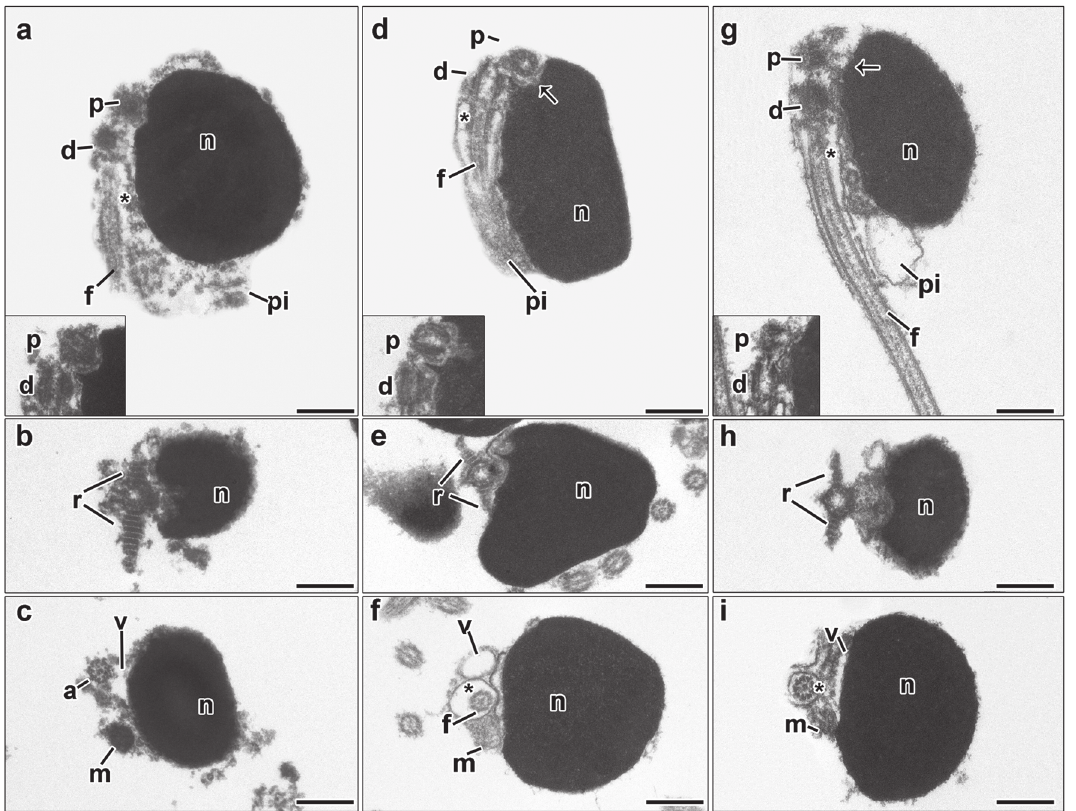
Fig. 2. Spermatozoon of Lebiasina aff. festae ( a, b, c ), L. bimaculata ( d, e, f ) and L. erythrinoides ( g, h, i ). a, d, g : longitudinal sections. b, c, e, f, h, i : transverse sections from top to posterior region. The nucleus (n) of all species is drop-shaped and slightly elongated towards the flagellar axis. The flagellum (f) lies lateral to the nucleus. The centriolar complex (p, d) and nuclear fossa (arrow) is superolateral. Note the presence of the striated rootlets (r) on opposite sides of the distal centriole (d). The proximal centriole (p) is slightly oblique relative to the distal centriole (d) (a-inset, d-inset, g-inset). The cytoplasmic canal is present (asterisk). The midpiece (pi) is short, asymmetrical, and contains the oblong mitochondria (m) and vesicles (v). a: axoneme, d: distal centriole, f: flagellum, m: mitochondria, n: nucleus, p: proximal centriole, r: striated rootlet, v: vesicle, asterisk: cytoplasmic canal, arrow: nuclear fossa. Bar = 0.5 μ